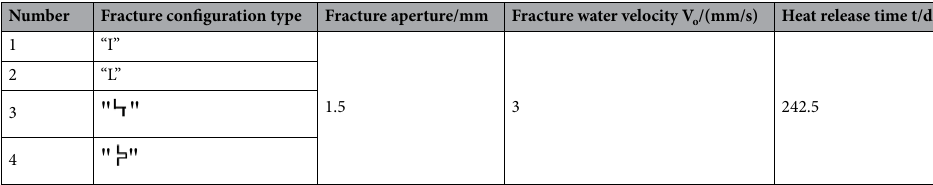
Table 2. Model calculate schemes.